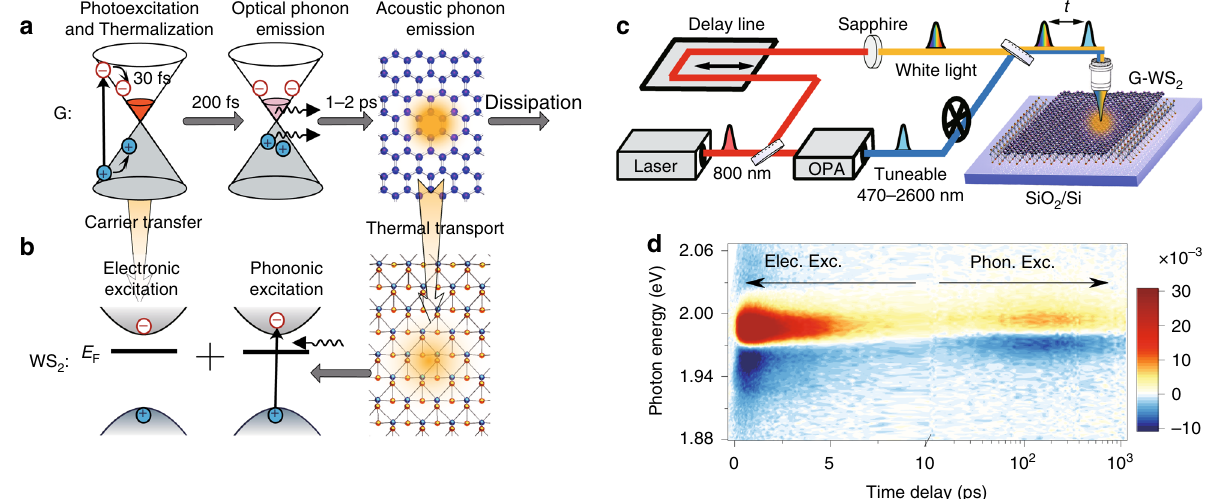
Fig. 1 Experimental realization and results. a Schematics of the electron and phonon dynamics in graphene after photoexcitation. The pump-excited electron-hole pairs thermalize in ~30 fs through carrier – carrier scattering, during which the absorbed photon energy remains in the electronic system. Subsequently, this energy is completely converted to lattice heat through optical (0.2 ps) and acoustic phonon (1 – 2 ps) emission. Without further treatment, the lattice heat will dissipate into the environment. b Monolayer WS 2 is utilized to collect the lattice heat in graphene through interfacial thermal transport and further deliver this lattice heat to the electronic system through thermal (phononic) excitation. In this heterostructure, a small portion of the initial hot carriers may directly transfer to WS 2 and induce electronic excitation. c Schematic of the TA measurement setup. d Typical 2D pseudo-colour TA map of the G-WS 2 heterostructure. Obvious electronic and phononic excitations of WS 2 are observed at timescales of <10 and >10 ps,